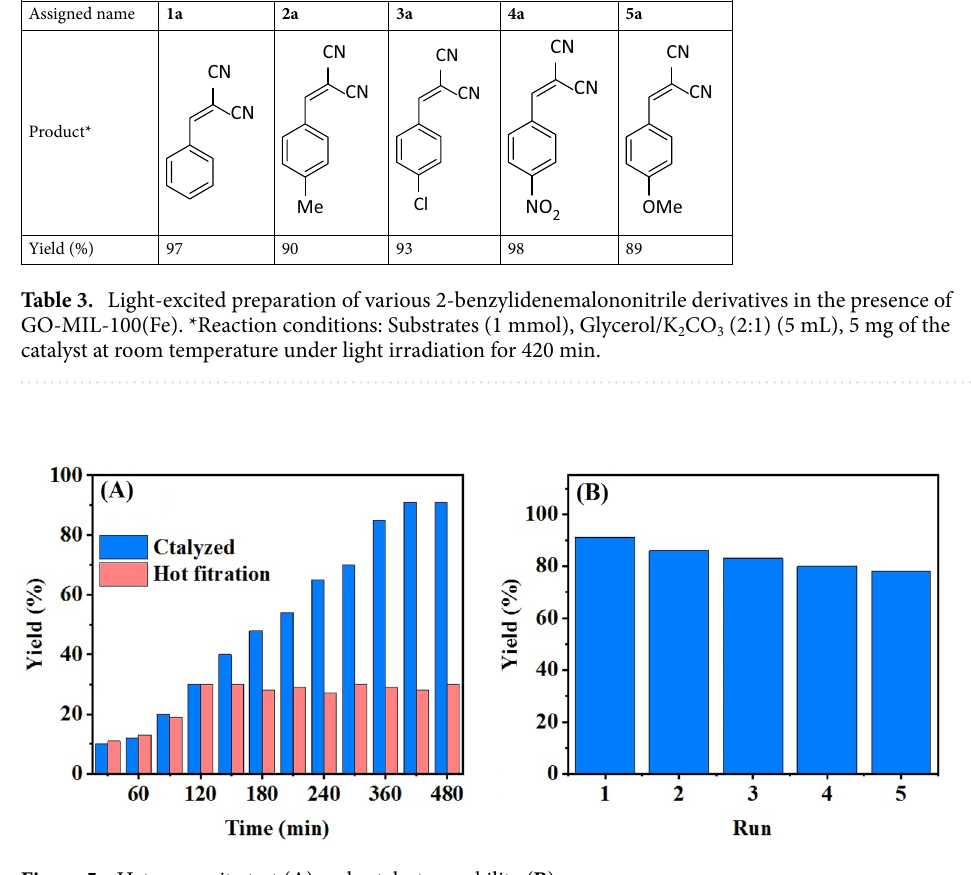
Figure 5. Heterogeneity test ( A ) and catalyst reusability ( B